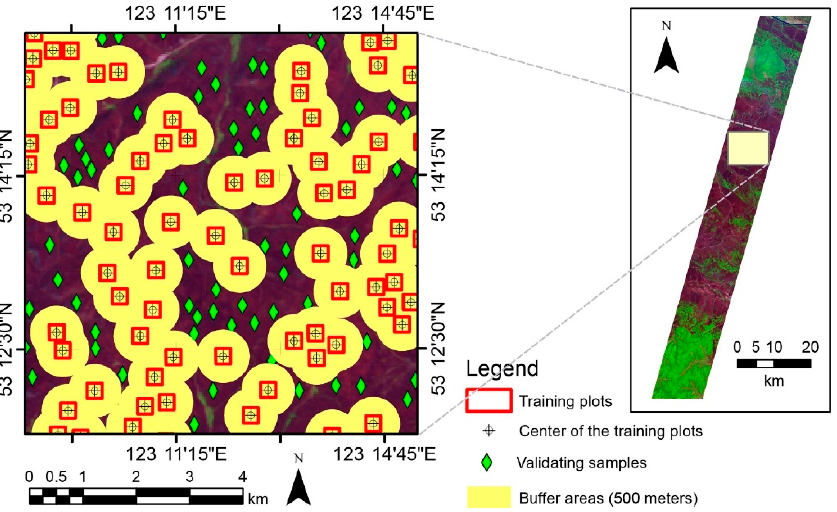
Figure 4. The location of training plots, training centers, and validating samples. Note that the illustration is a part of the study area.